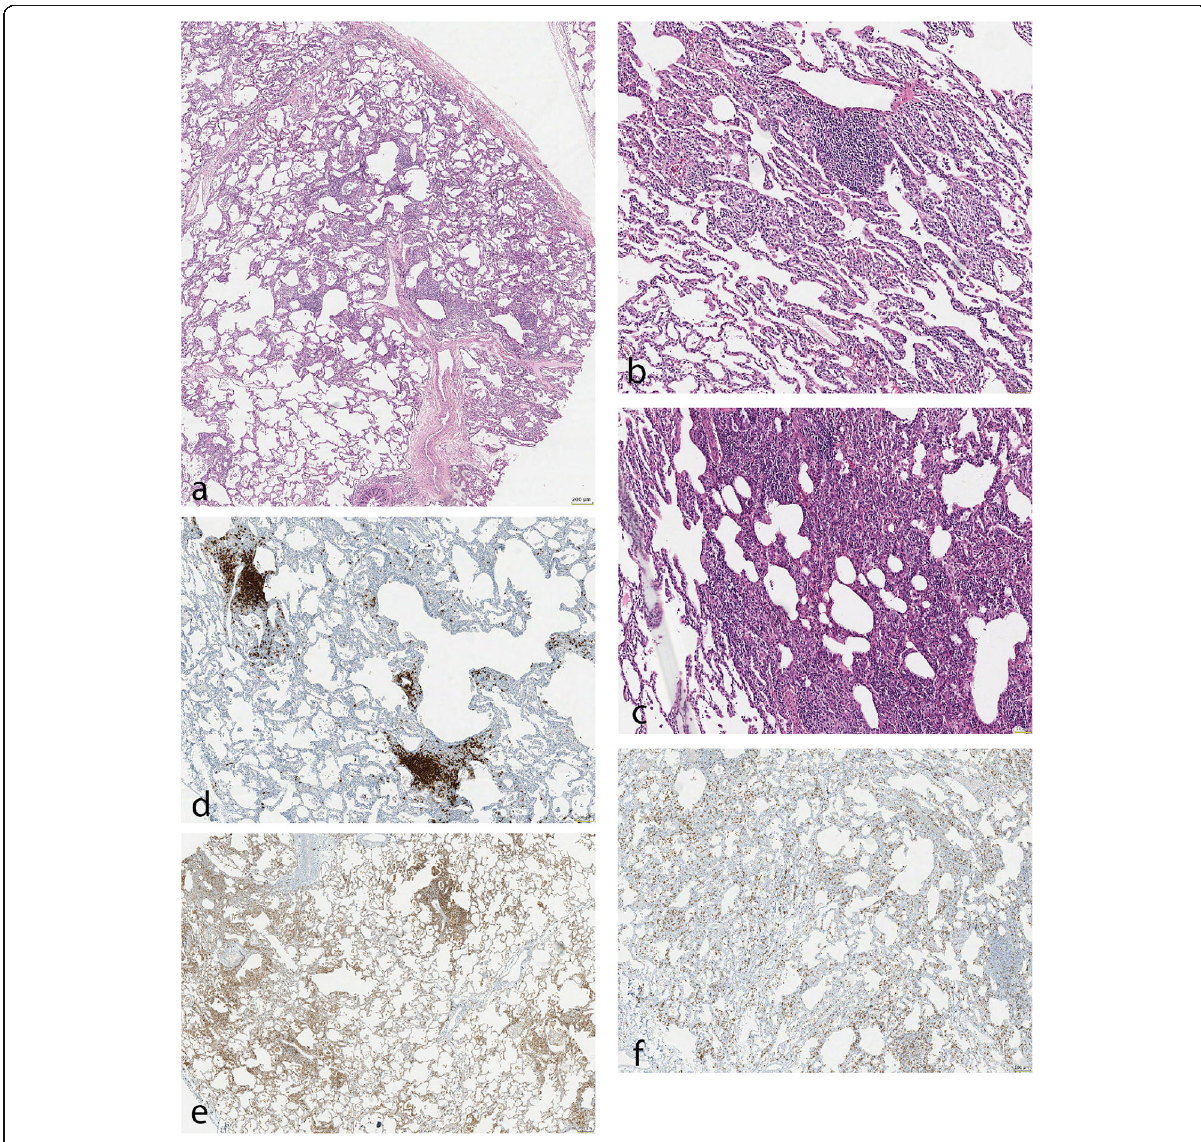
Fig. 15 rhA, acute form with LIP pattern; in this case the diagnosis of juvenile rhA was established. a ) overview, b and c ) LIP with hyperplasia of BALT; d ) CD20 positive lymphocytes, e ) lymphocytes positive for CD4, and f ) CD8 positive lymphocytes. This immune reaction excluded hypersensitivity pneumonia. H&E and immunohistochemistry, bars 200, 100, and 50 μ m,